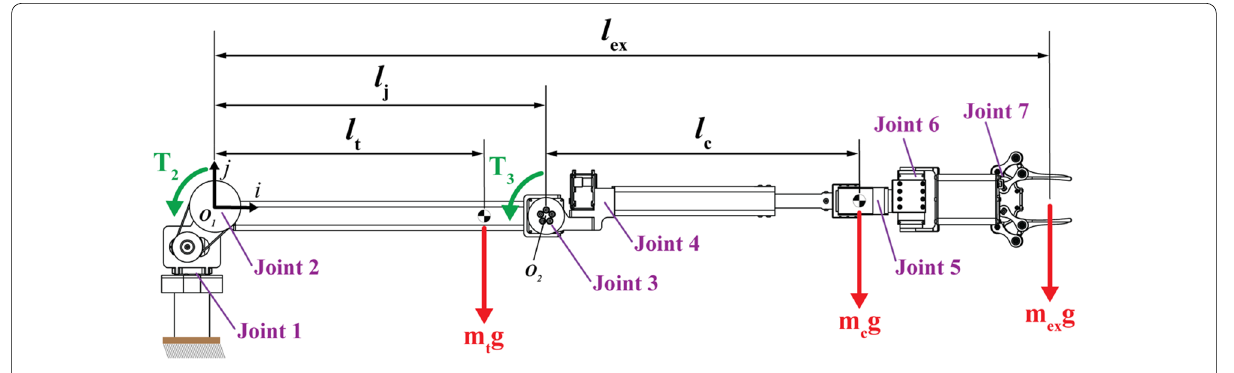
Fig. 10 Free body diagram of manipulator when it is